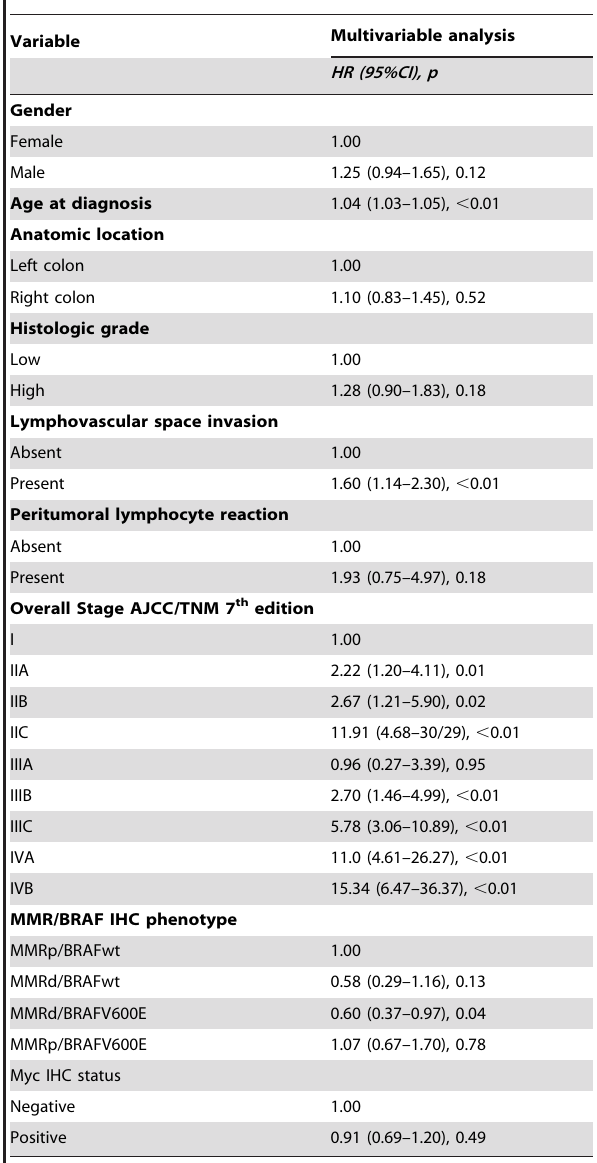
Table 4. Multivariable Cox regression proportional hazards analysis of 1421 CRCs including myc IHC status and MMR/ BRAF IHC phenotype interaction